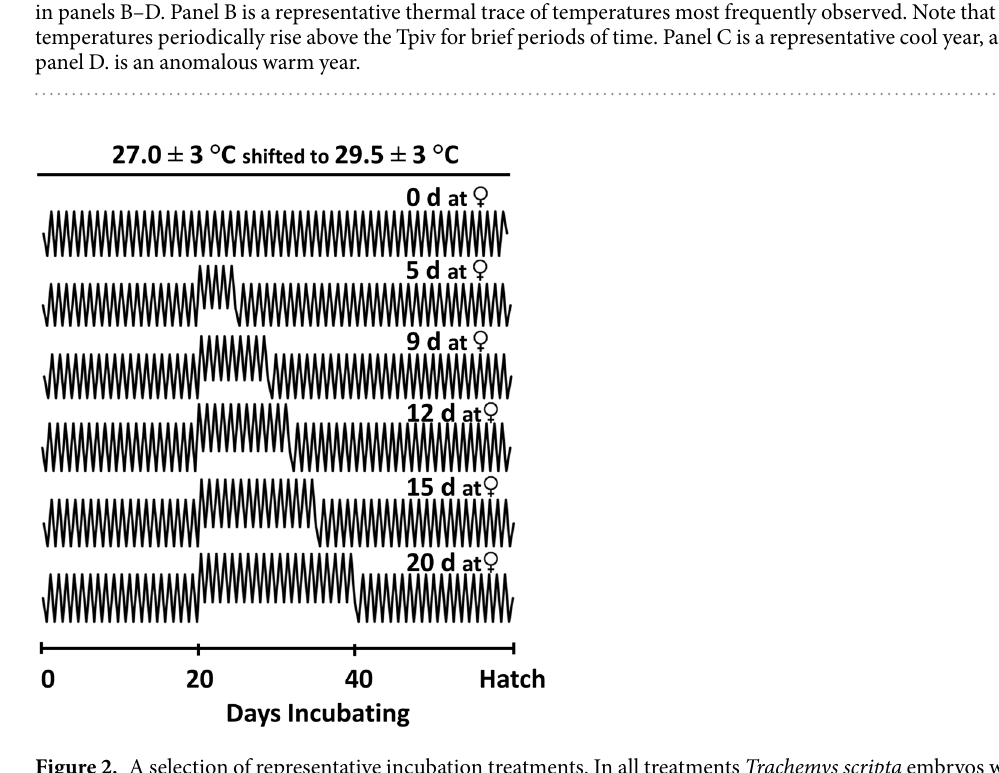
Figure 2. A selection of representative incubation treatments. In all treatments Trachemys scripta embryos were incubated at male producing temperatures (27 ± 3 °C) for the first 20 days of incubation, then eggs were moved to female producing temperatures (29.5 ± 3 °C) for variable durations, after which they were returned to the male temperatures for the remainder of incubation. See the methods for all the incubation duration treatments utilized in each